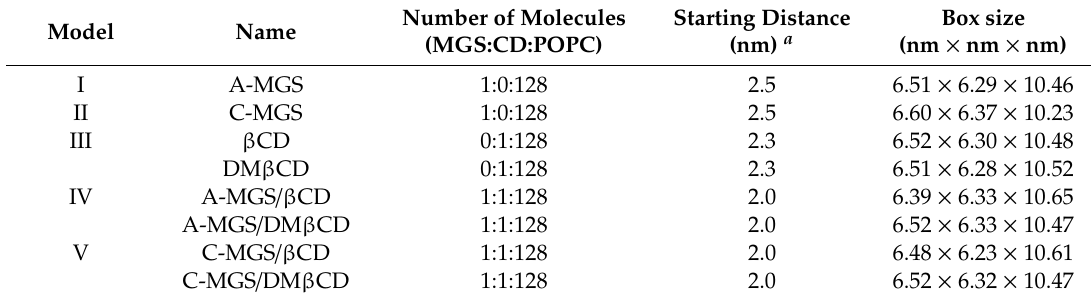
Table 1. Details of the five models of free-MGS, free- β CDs, and MGS / β CDs complexes. The number of component molecules, the starting distance of the focused compound from the center of the POPC membrane bilayer (z = 0 nm) and simulation box dimensions in each system are also